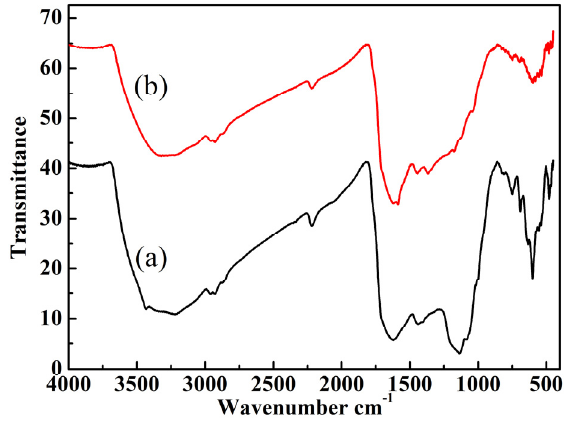
Figure 10. FTIR spectra of α -Fe 2 O 3 @PHCMs before ( a ) and after ( b ) three repeated treatments.